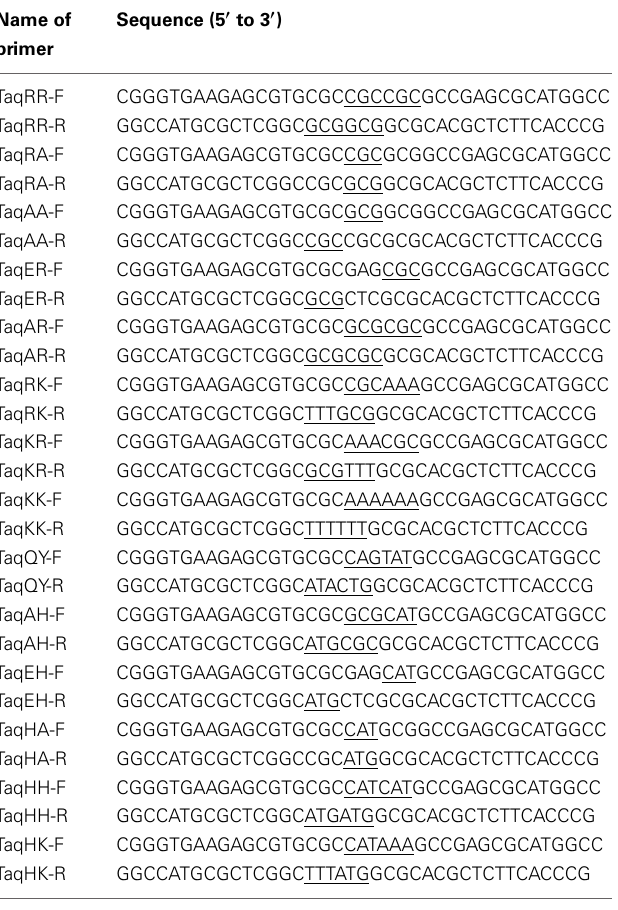
Table 1 | Oligonucletides used to introduce mutations into positions 742 and 743 of Taq